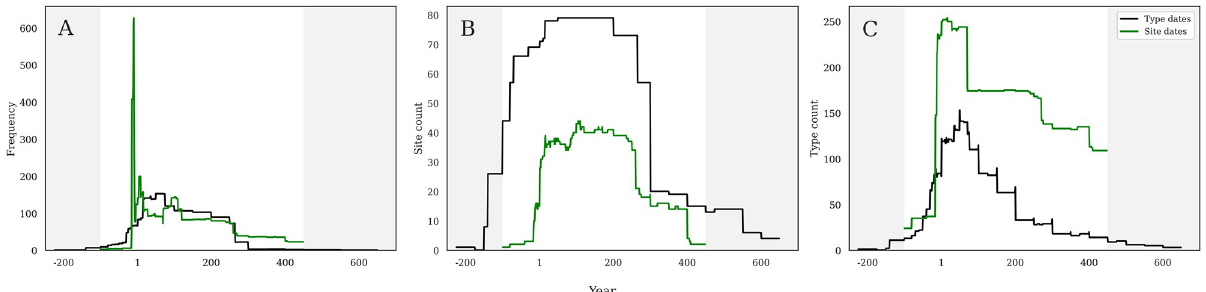
Fig 3. a-c. Chronological methods. Comparison of type date (green) and site date (black) chronologies across the three different methods of analysis. Note that Y axes are not constant.